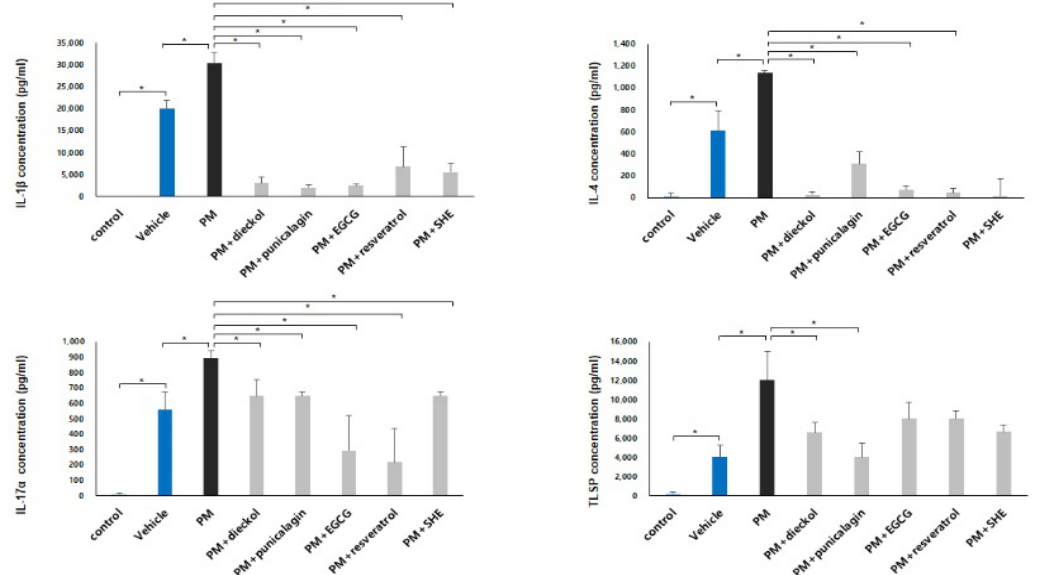
Figure 5. Preventative effects of antioxidants on the upregulation of inflammatory cytokines pro- tein expression in the particulate matter <10 µ m (PM 10 )-treated, 2,4-dinitrochlorobenzene (DNCB)- induced atopic dermatitis mice. The protein expression of interleukin (IL)-1 β , IL-4, IL-17 α , and thymic stromal lymphopoietin (TSLP) was also significantly decreased after combined treatment with dieckol, punicalagin, epigallocatechin-3-gallate (EGCG), resveratrol, or Siegesbeckiae Herba extract (SHE) compared with that after PM 10 treatment only. The data in the bar graphs represent the mean ± standard deviation (SD) of three independent experiments (* p <